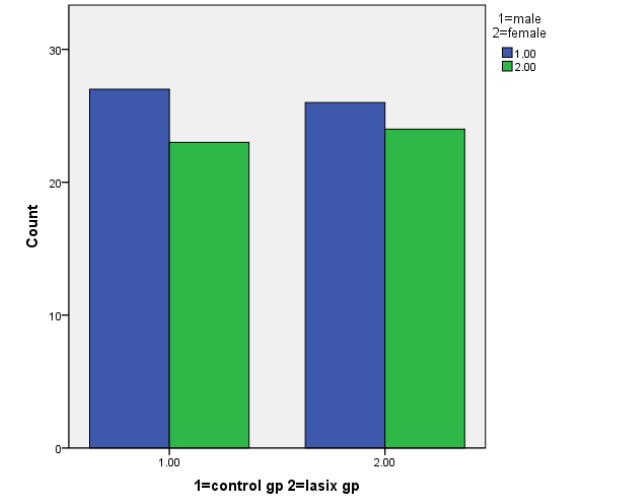
Figure (2): shocked patient received 2 ml normal saline group versus shocked patients received 2 ml Furosemide group in sense of gender, there is no significant statistical differences (p=0.421)